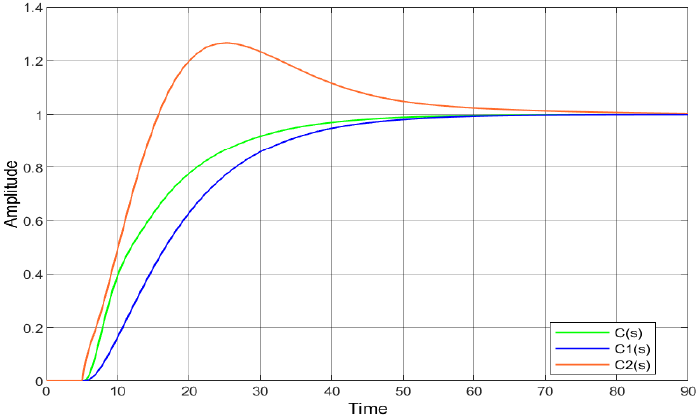
Figure 9. Simulated response under a desired reference step using two different controllers in the closed-loop system shown in Figure